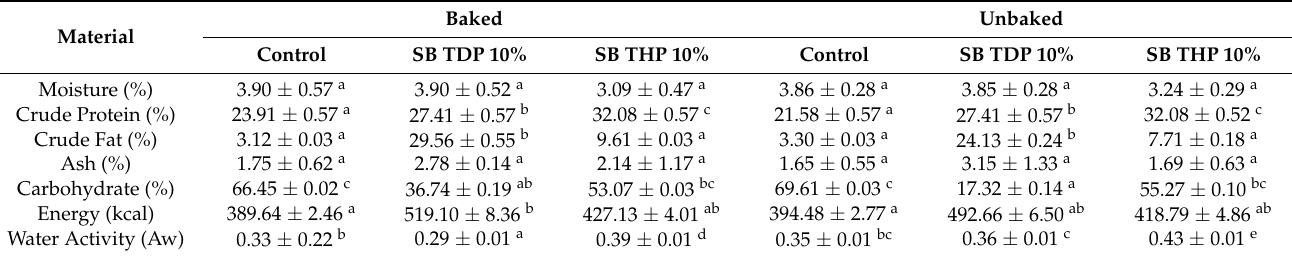
Table 5. Proximate analyses of snack bar